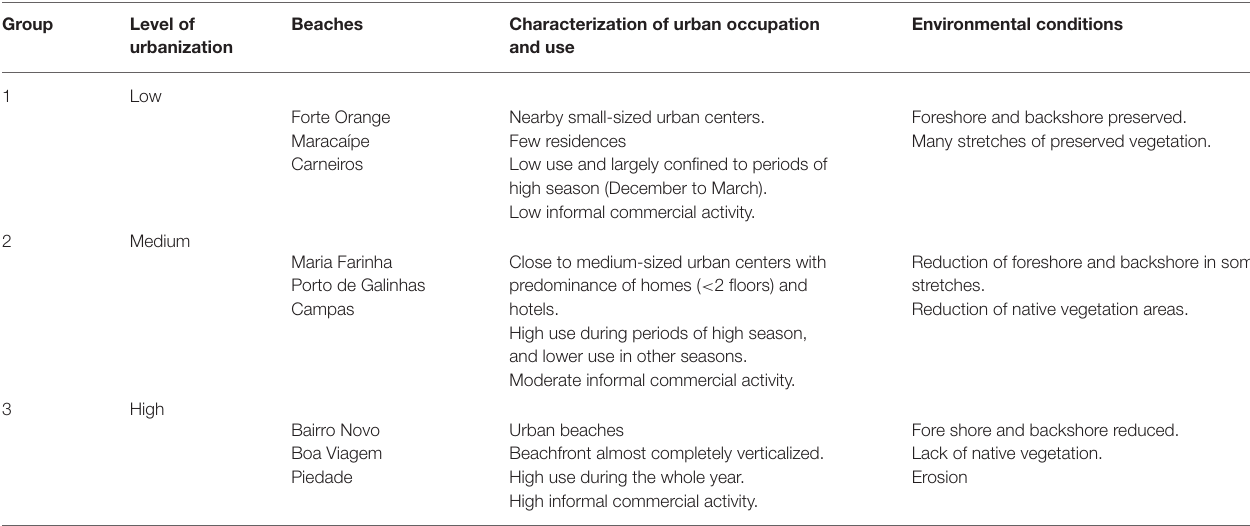
TABLE 1 | Characteristics of the studied beaches based on type of use and occupation of land, which determined the environmental conditions of the studied area ( Araújo and Costa, 2008).